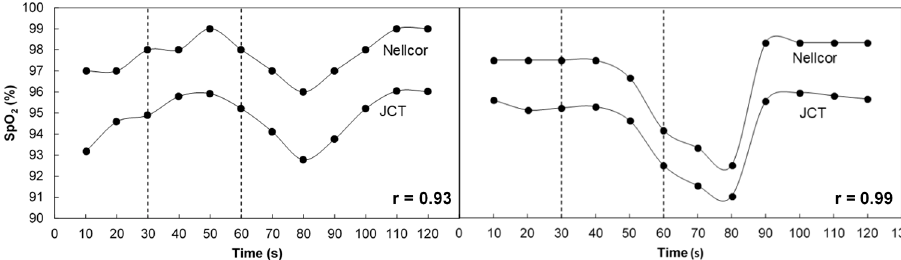
Figure 5. SpO 2 values of two examinees as a function of time, as measured by the two pulse oximeters. The period of breath holding is demarcated by the two vertical lines.